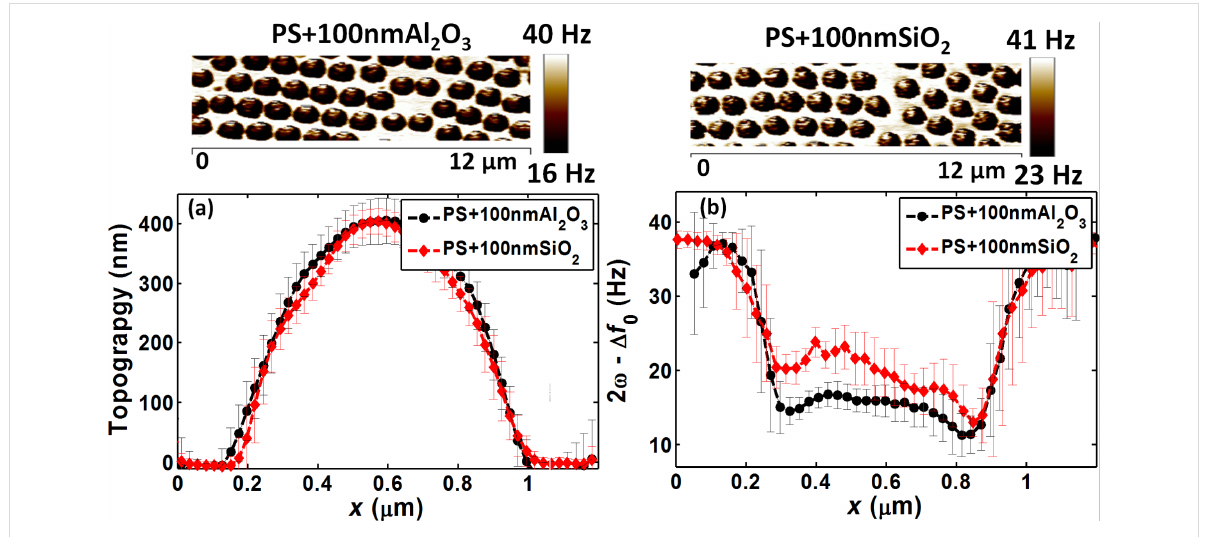
Figure 8: Approach 3 (step A) PS + 100 nm Al 2 O 3 and PS + 100 nm SiO 2 samples: (a) Average topography profiles, (b) average EFM signal profiles, and their corresponding EFM images (upper panels).